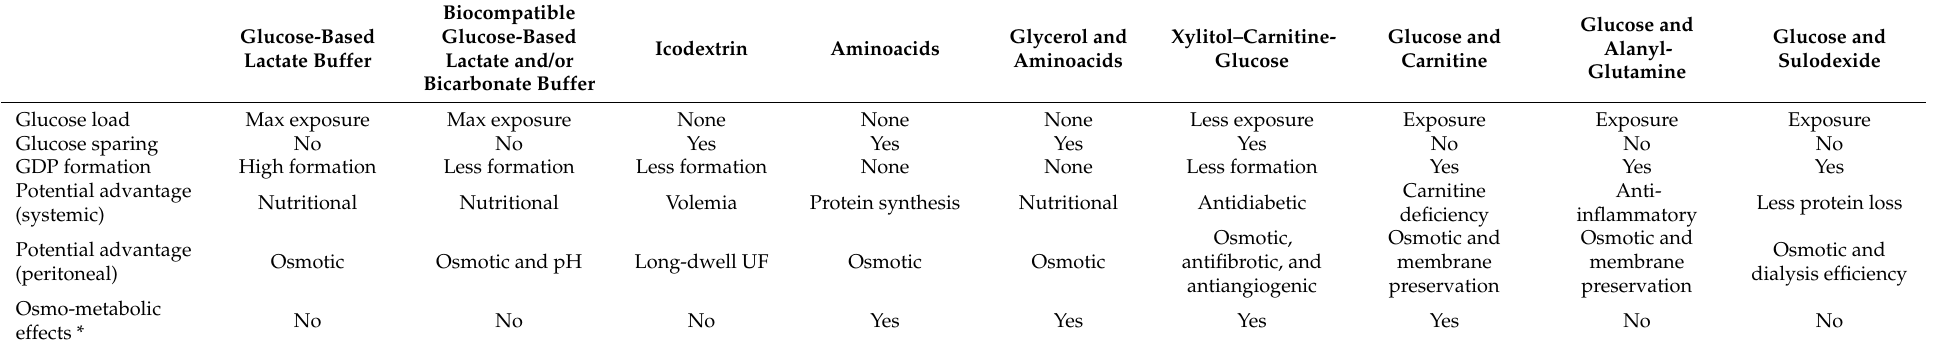
Table 2. Main advantages and disadvantages of peritoneal dialysis solutions tested in vivo in dialysis